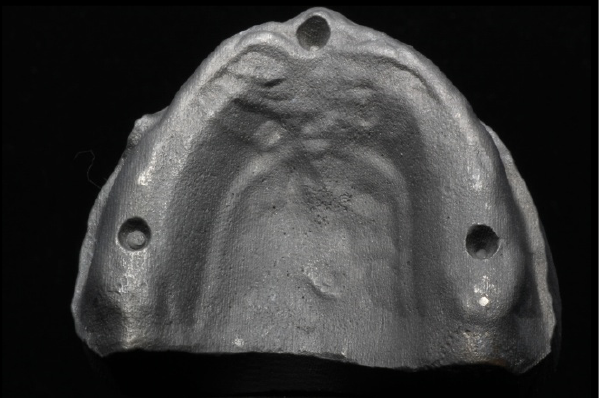
Figure 2. Titanium high-alveolar-ridge master model for sample construction.